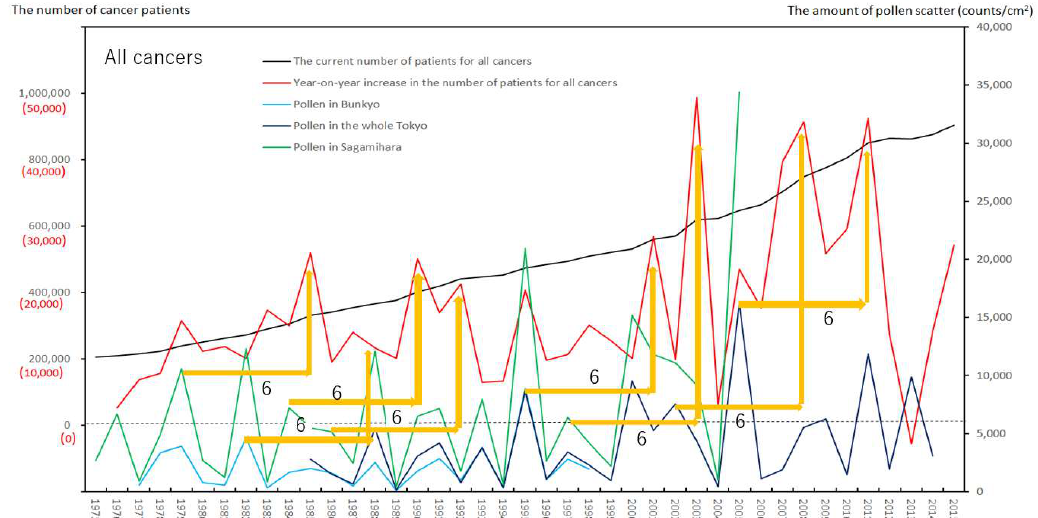
Figure 1. The current number of Japanese males and females (presently registered patients) registered for all cancers at the year diagnosed, its year-on-year increase (newly registered patients), and the amount of air borne pollen scatter in 3 areas during the period from 1975 to 2015. The line graphs for all cancers representing numbers of presently and newly registered patients in each year, as well as the amount of pollen scattered in Bunkyo-City area of Tokyo, the whole Tokyo Metropolitan area and Sagamihara City during the period from 1975 to 2015. Orange arrows indicate phasic increments of newly registered patients occurring six years after phasic increments of airborne pollen scatter. Numbers of patients are shown on the left axis whose scales consist of red numbers for newly registered patients and black numbers for presently registered patients. Pollen numbers in counts/cm 2 are shown on the right axis.